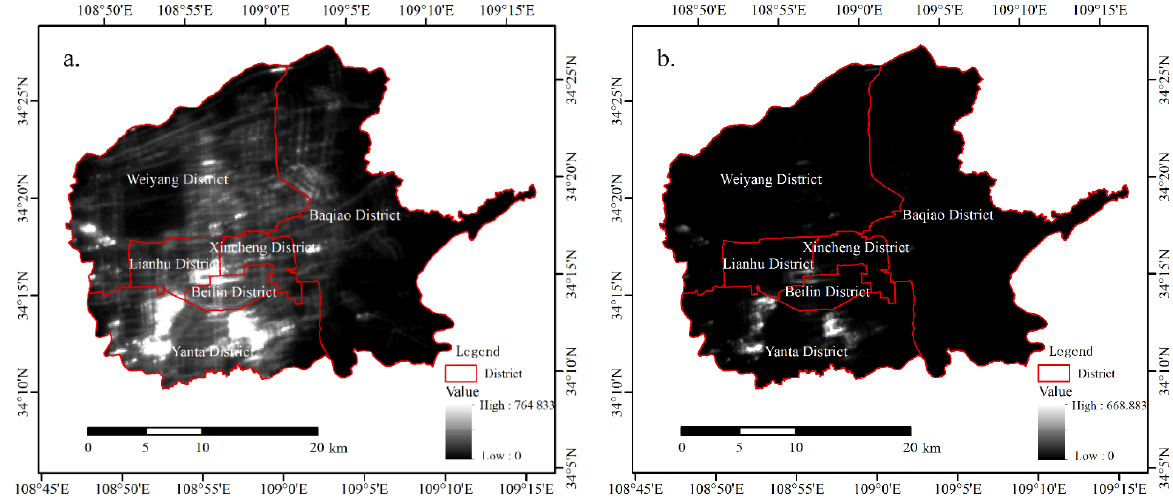
Figure 3. Comparison of ( a ) before and ( b ) after image correction.